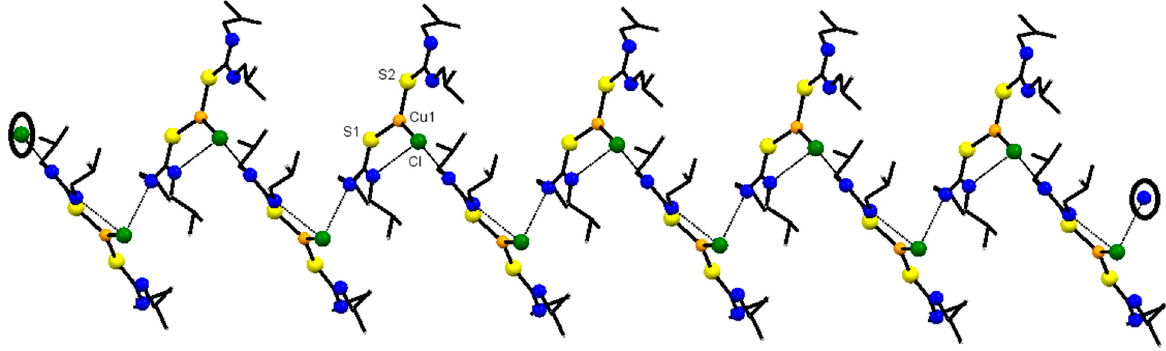
Figure 2. 1 D representation of Complex 1, the infinite pseudo-polymeric zigzag chain stabilized by intermolecular NH … Cl interactions. Hydrogen atoms are omitted for clarity and hanging contacts at both ends of the chain are encircled to make them prominent. Intramolecular NH … Cl interactions are also indicated.